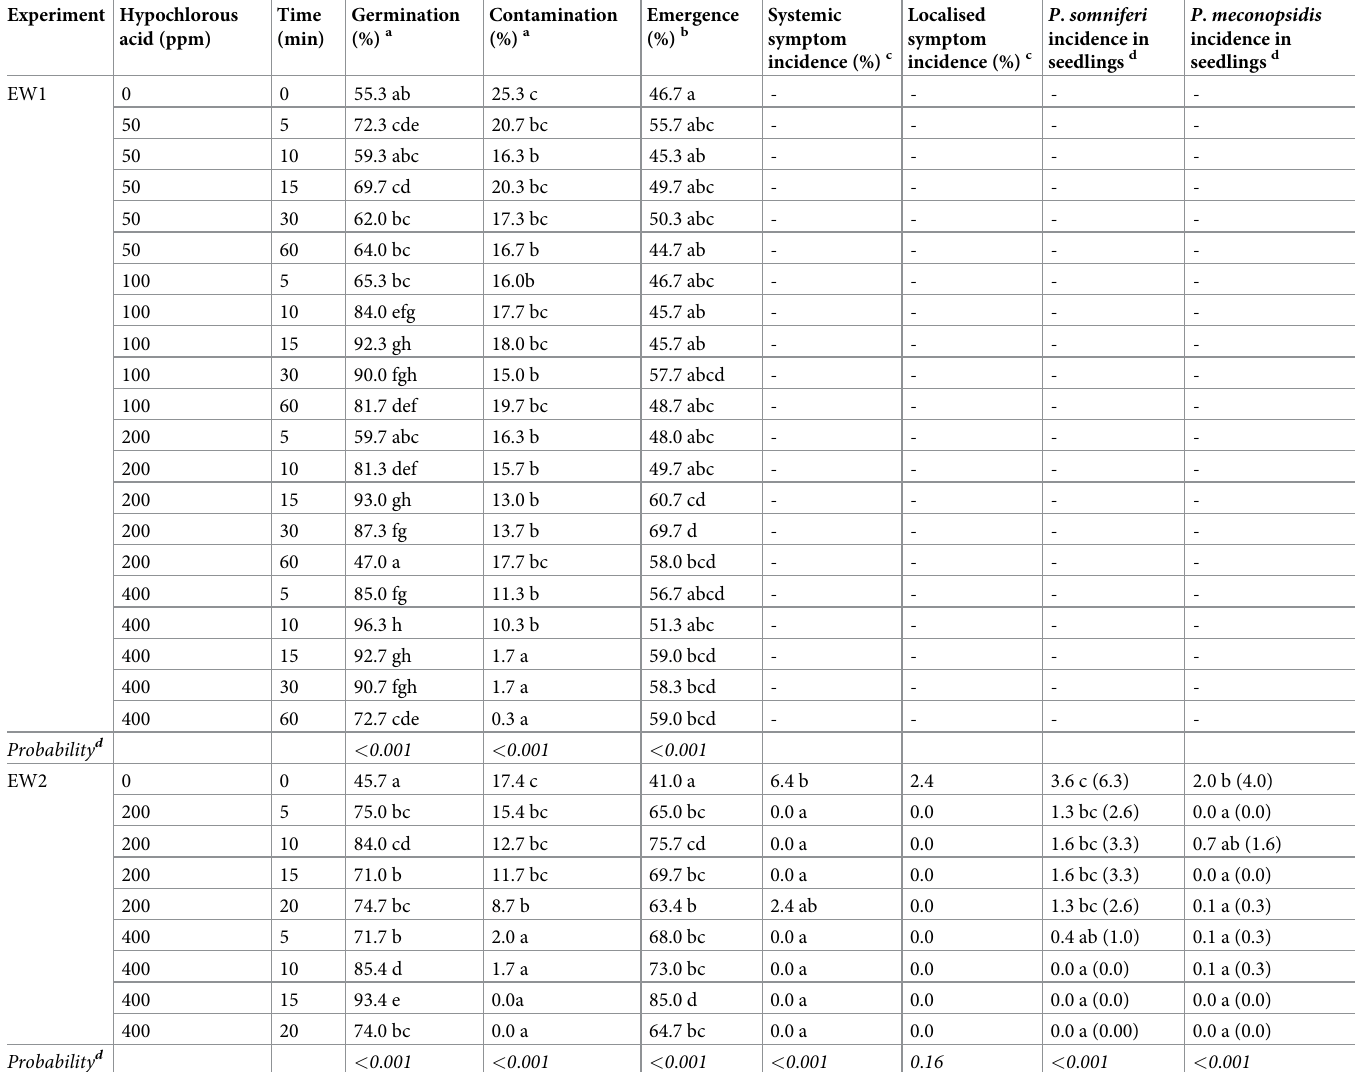
Table 3. The effect of electrolysis water treated at various concentration and time on the opium poppy seed health and controlling poppy downy mildew. Experiment Hypochlorous acid